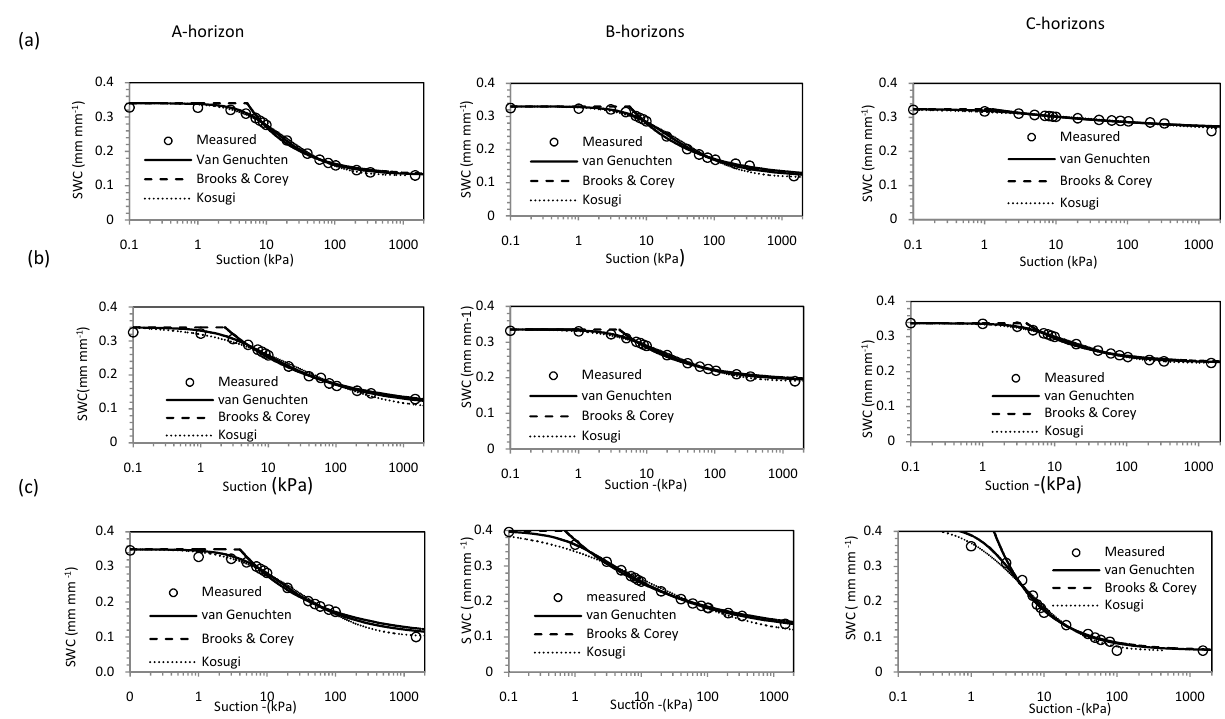
Fig. 2. Soil water characteristic curves from measured laboratory experiments and fitted using three pore size distribution models. N = 3 samples from A, B and C horizons of the Tukulu, Sepane and Swartland soil profiles. Desorption approach; undisturbed core samples from 0–100kPa, disturbed samples from 100-1500 kPa.